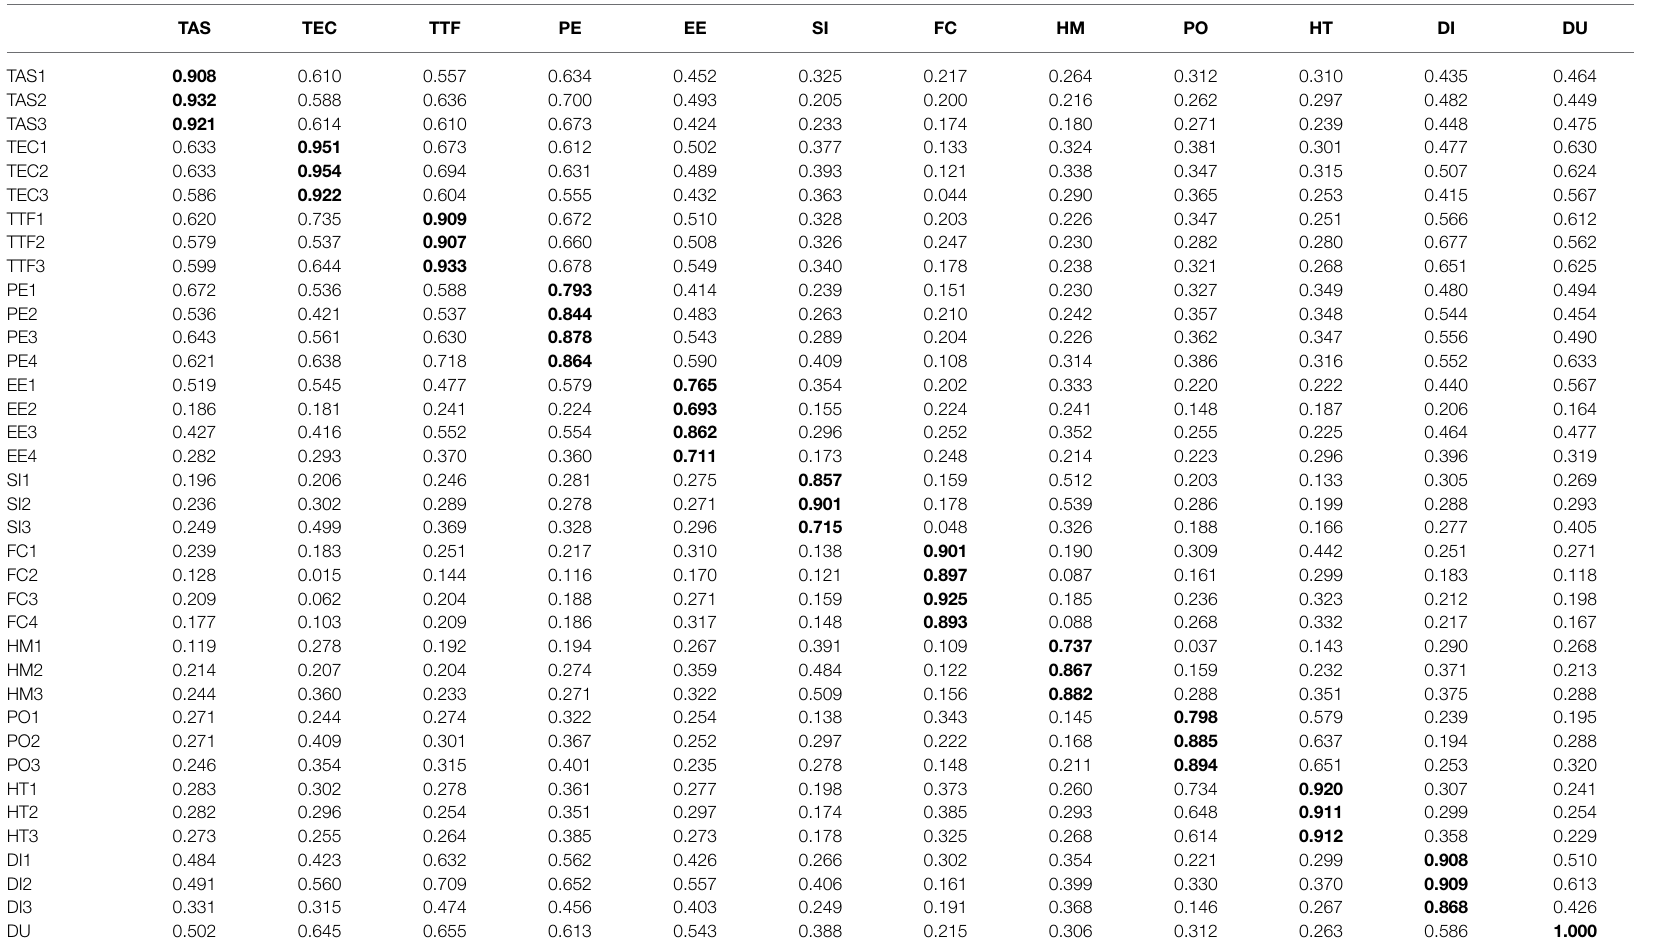
TABLE 4 | PLS-SEM factor loadings (bold) and cross loadings.